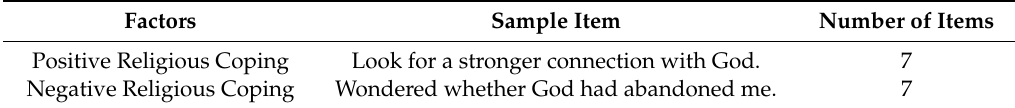
Table 1. Religious Coping Scale (RCOPE) Subscales and Sample Items.